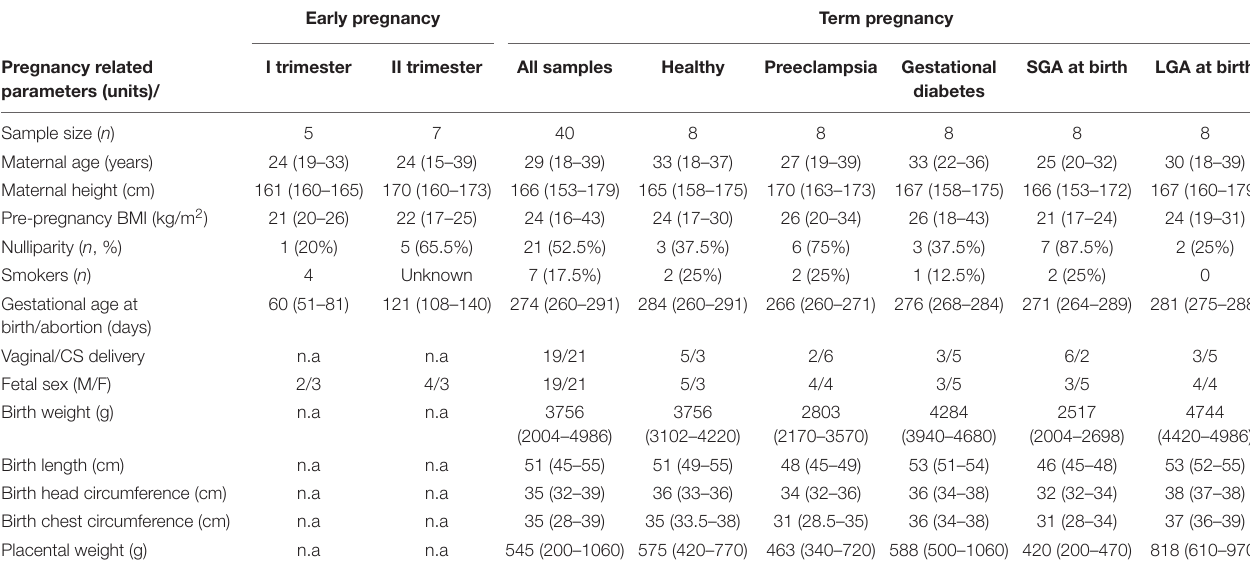
TABLE 1 | Clinical characteristics of the pregnancies profiled for the placental